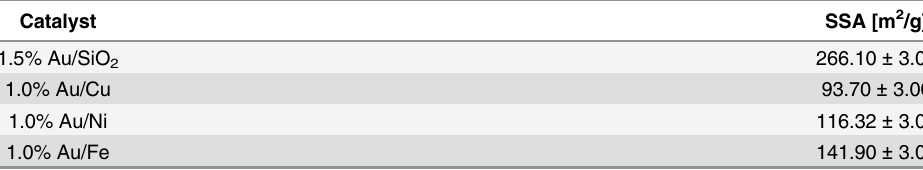
Table 1. Specific surface area (SSA) of the tested catalysts.